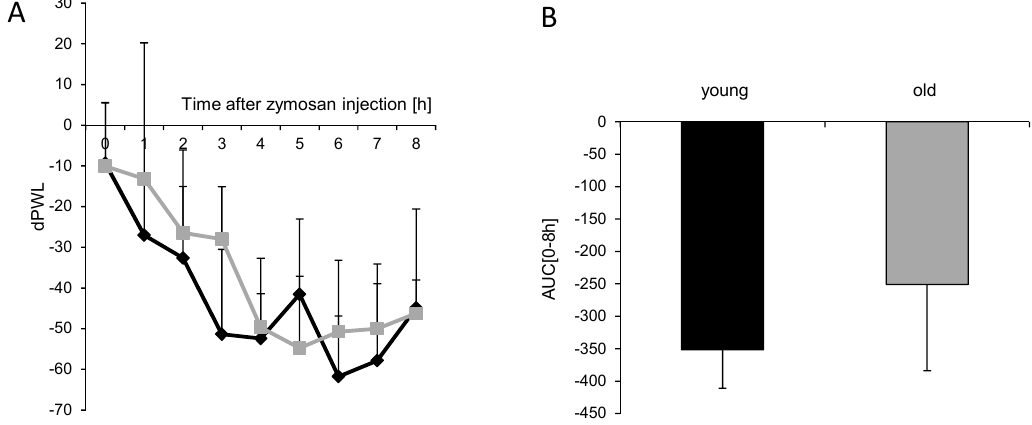
Figure 2. Inflammatory nociception in the zymosan-induced paw inflammation. ( A ) Time course of mechanical hypersensitivity in young ( ∎ ) and old mice ( ) after injection of 10 mg/mL (20 µL) zymosan A into a hind paw. The diagram shows the delta paw withdrawal latencies ( Δ PWL) in response to mechanical stimulation, as assessed with a Dynamic Plantar Aesthesiometer; ( B ) Comparison of the area under the paw withdrawal latency versus time curve between young (black column) and old (grey column) mice 0 to 8 h after zymosan A injection. ( n = 6 mice/group). To rule out the decreased sensitivity of old mice being due to motor deficits or decrease of nociceptive fibers and already apparent in acute nociception, we assessed the motor functions in the Hanging wire test and the nociceptive reaction upon acute noxious cold, heat, and mechanical stimulation. In all of these tests, we found no difference between the two groups (Table 1), indicating that motor function and acute nociception are normal in old mice. Table 1. Effects of age on acute nociception.